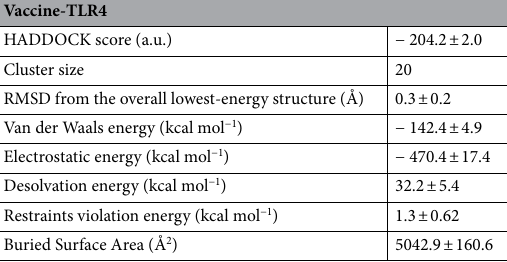
Vaccine-TLR4 HADDOCK score (a.u.) − 204.2 ±